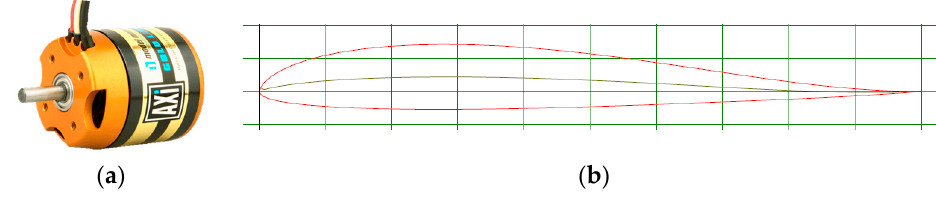
Figure 3. ( a ) AXi 4130 / 20 kv305 brushless electric motor and ( b ) s5010 airfoil profile.